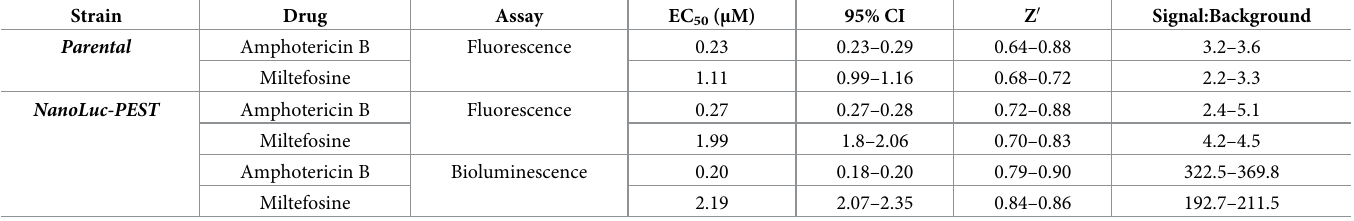
Table 1. EC 50 values and assay parameters following treatment with Amphotericin B and Miltefosine against wild-type and NanoLuc-PEST expressing L . mexicana (see S5 Fig for full dataset). Strain Drug